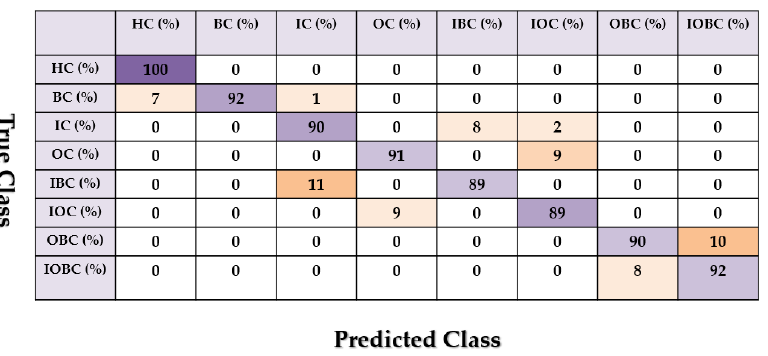
Figure 14. The average of crack type diagnosis using the combination of the ALSGL - SBI and SVM approaches.